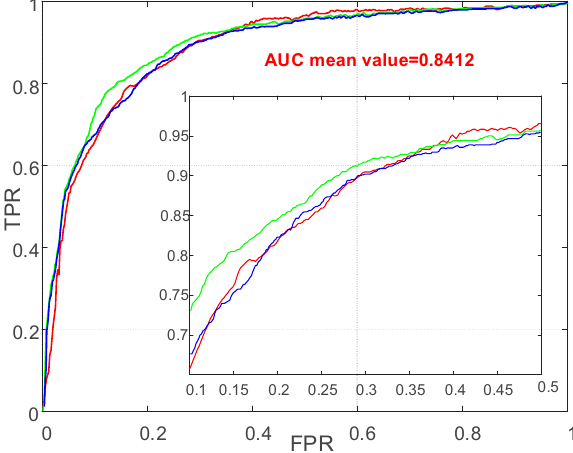
Figure 8. ROC curve detected RF algorithm without K-SMOTE.